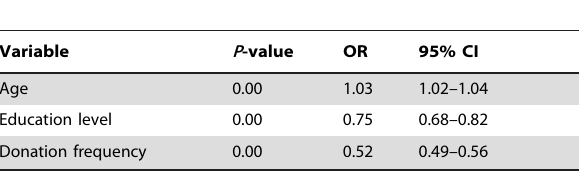
Table 6. Influencing factors of transfusion-transmissible infections prevalence,